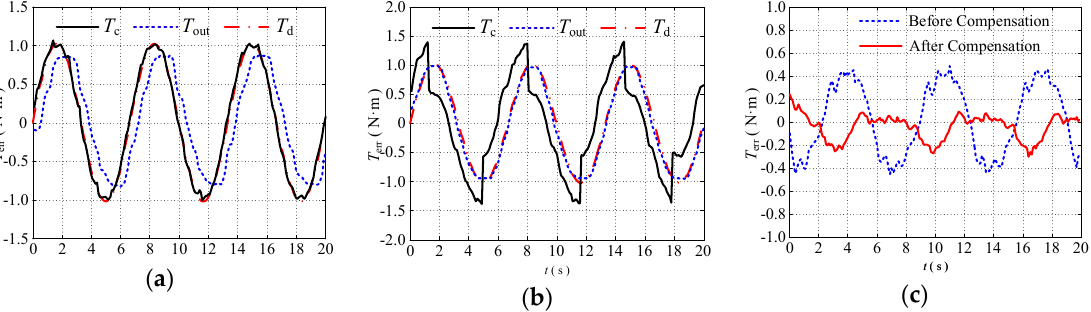
Figure 11. Torque tracking experiment with 2.5 kg end load under external disturbance; ( a ) before compensation; ( b ) after compensation; ( c ) torque tracking error.